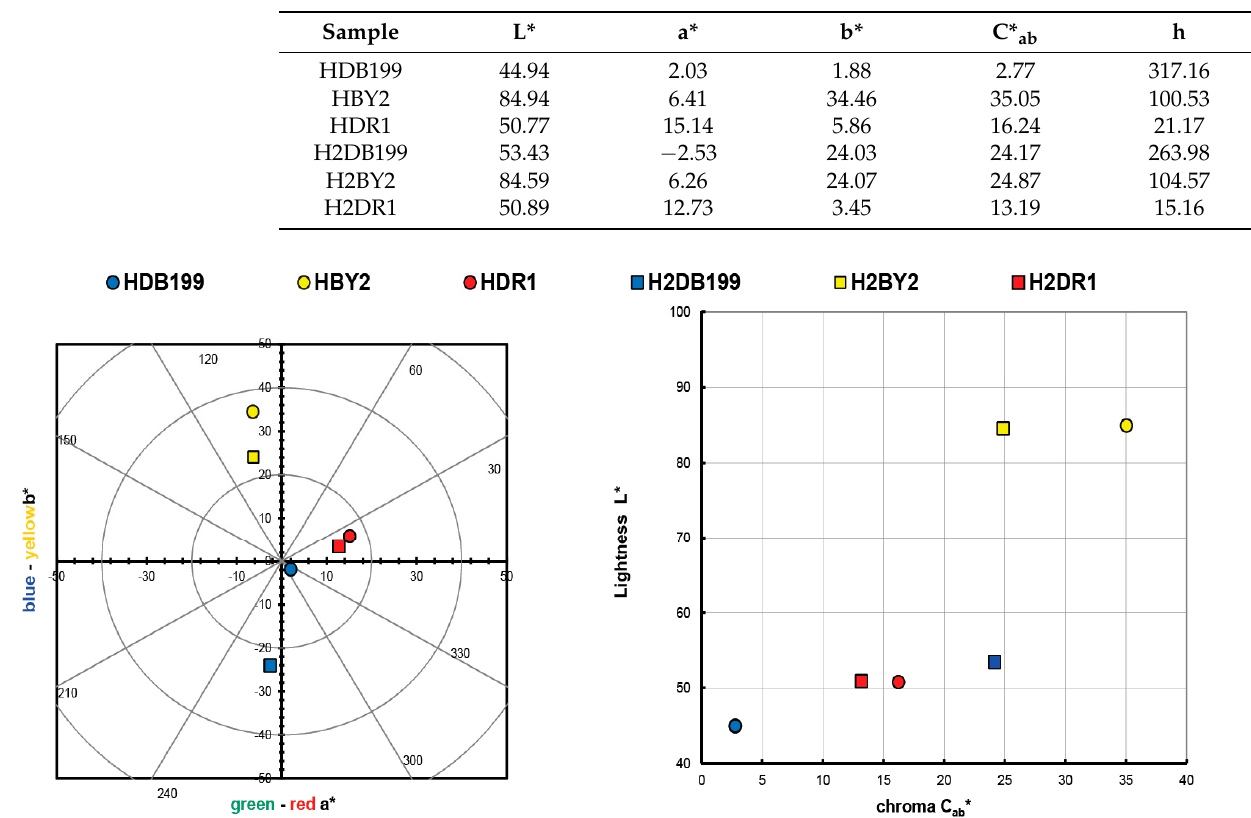
Figure 1. Graphic CIELAB plots for hybrid pigments synthesised using the D65 illuminant and the CIE-1931 XYZ standard observer. ( Left ): CIE-a*b* color diagram; ( right ): CIE-Cab*L* color Table 2. Values L *, a *, b *, C * ab and h of each hybrid.